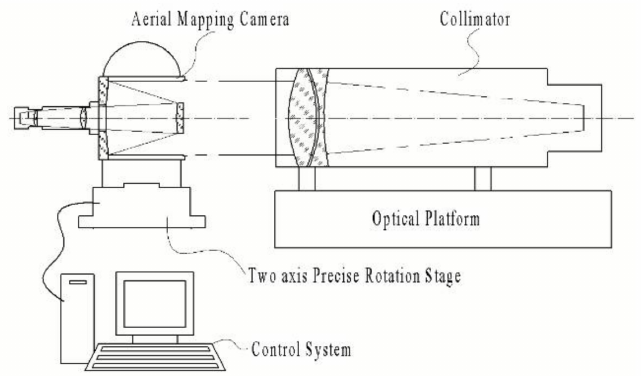
Figure 12. Interior orientation element calibration experiment platform of the mapping camera.